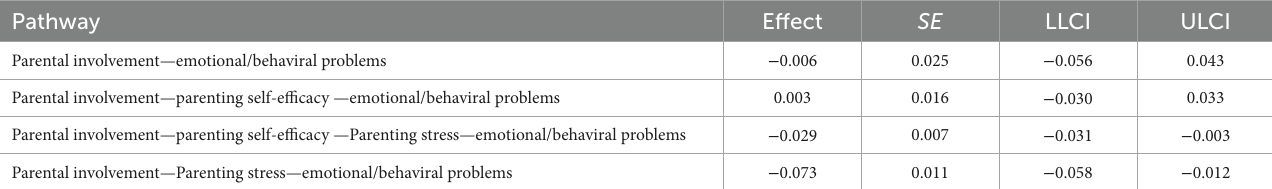
TABLE 5 Standardized indirect effects and 95% CIs for the mediational model. Pathway